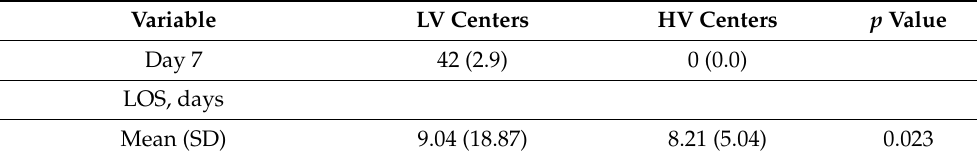
Percentages calculated based on the number of free flaps. n , number; SD, standard deviation; min, minutes; LOS, length of hospital stay; LV, low-volume; HV, high-volume. Interestingly, outcome analysis showed a significantly higher rate of total flap loss within the HV-group (LV: 1.2% vs. HV: 2.4%; p = 0.014), whereas partial flap loss was comparable between groups ( p = 0.327). Emergent vascular revision was performed in 4% (LV) and 4.5% (HV) of cases, without showing statistical significance ( p = 0.453). Revision surgery due to wound complications was, however, performed significantly more often in the LV group (LV: 10.8% vs. HV: 7.1%; p < 0.001). This was related to a significantly higher